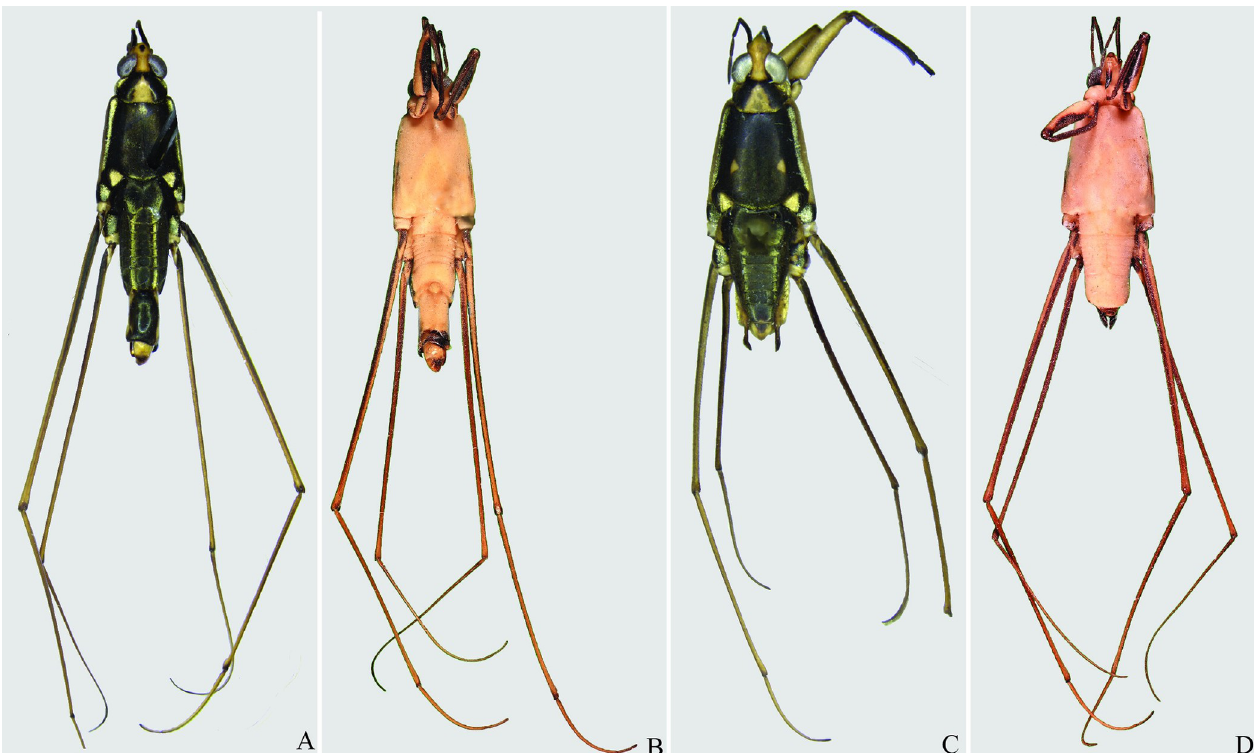
Fig 30. Potamobates peruvianus . (A) Male, dorsal view; (B) male, ventral view; (C) female, dorsal view; (D) female, ventral view.